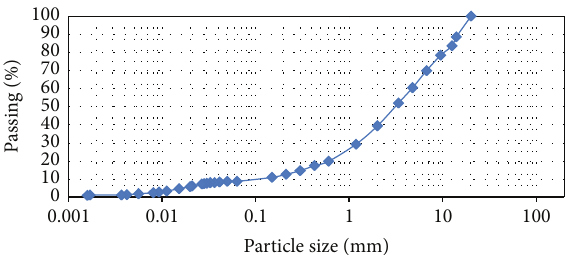
Figure 5: Trend of maximum dry density with increasing coal bottom ash